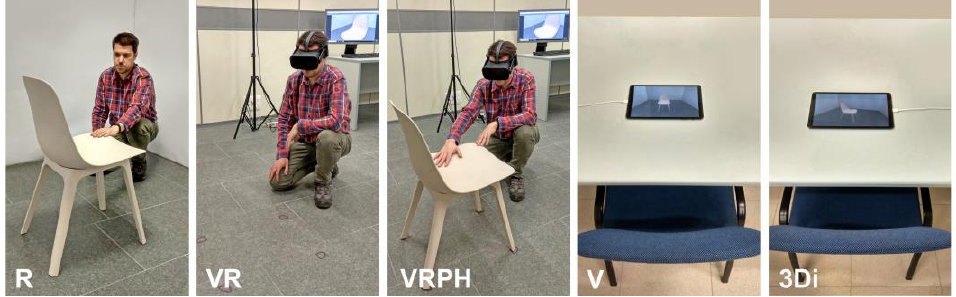
Figure 1. The five rooms used during the